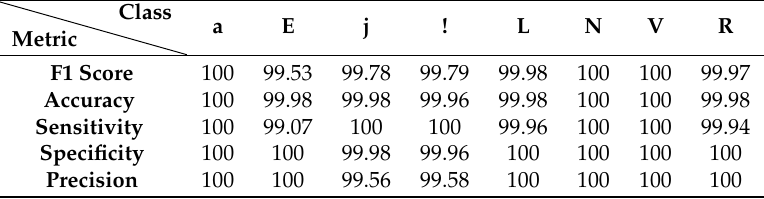
Table 13. Performance of the best solution on experiment 2 in percentage.